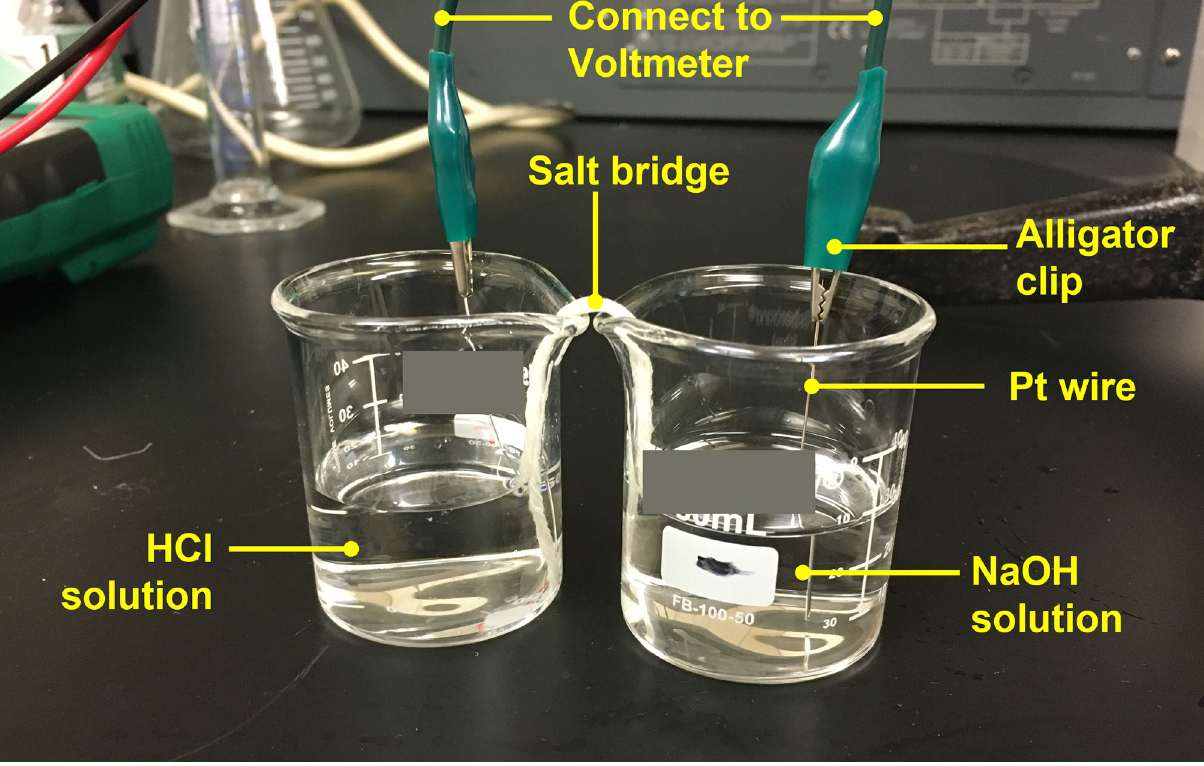
Fig 1. A photo of the electrochemical